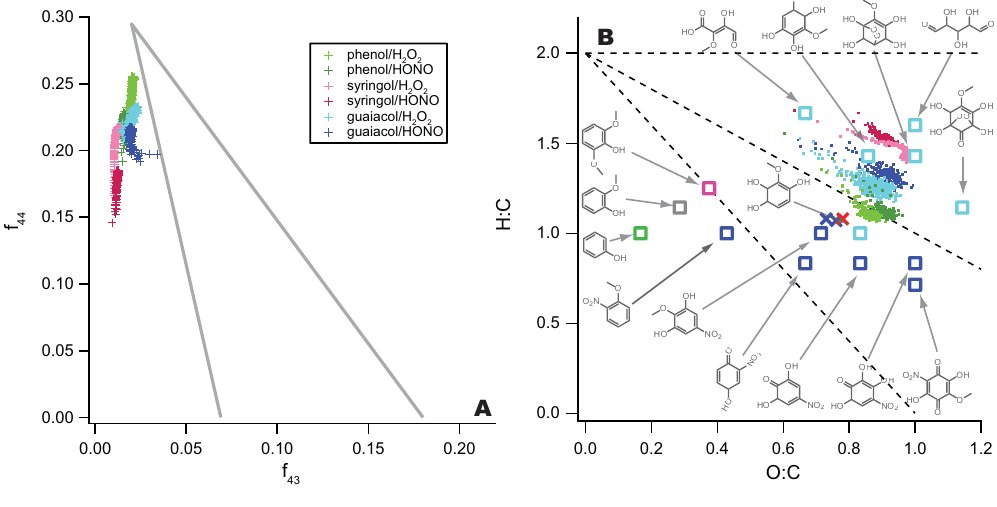
Fig. 6. (a) “Triangle plot” for SOA formed from photooxidation of phenol, guaiacol, and syringol under low- and high-NO x conditions. Experiment progression is from bottom to top. (B) Van Krevelen diagram for SOA formed from photooxidation of phenol, guaiacol, and syringol under low- and high-NO x conditions. Identified guaiacol-SOA products of high- and low-NO x conditions are presented dark and light blue boxes respectively. Elemental ratios as measured by FTIR data are represented by red (low-NO x ) and blue (high-NO x ) crosses. Quantification of molecular species in methoxyphenol SOA systems has not yet been